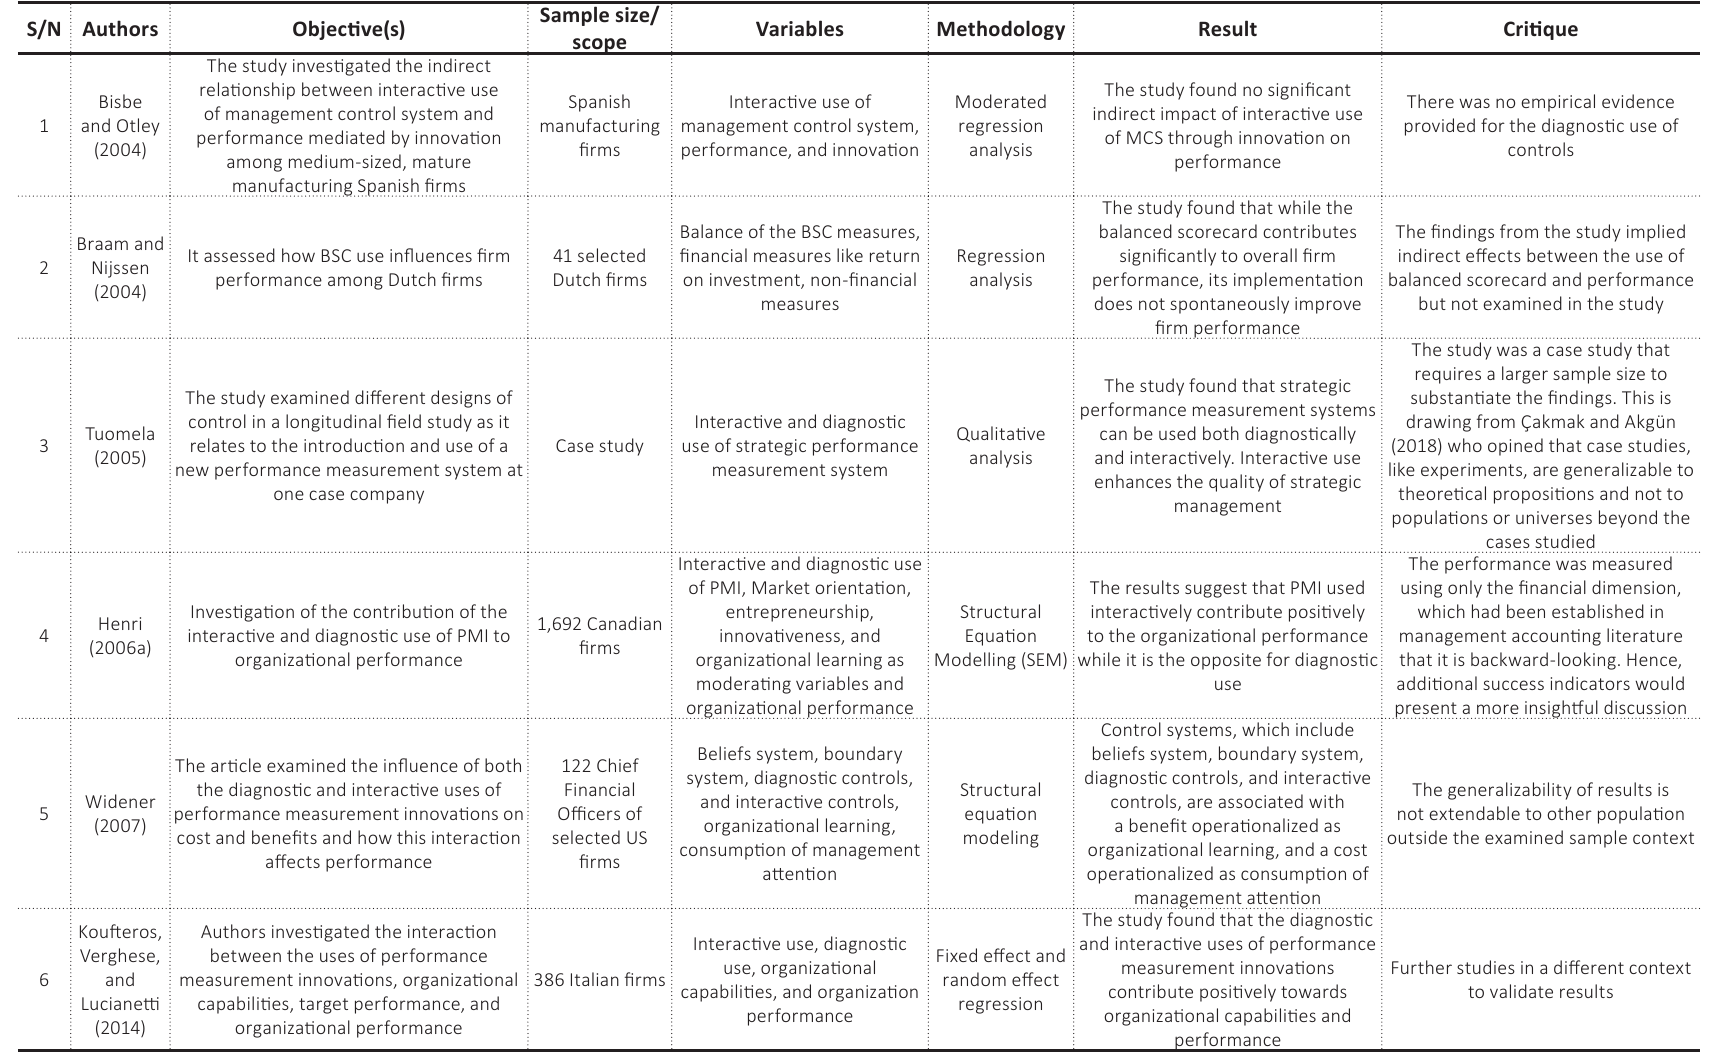
Table 1. Summary of relevant studies on diagnostic and interactive uses, design of performance measurement innovations, and organizational outcomes S/N